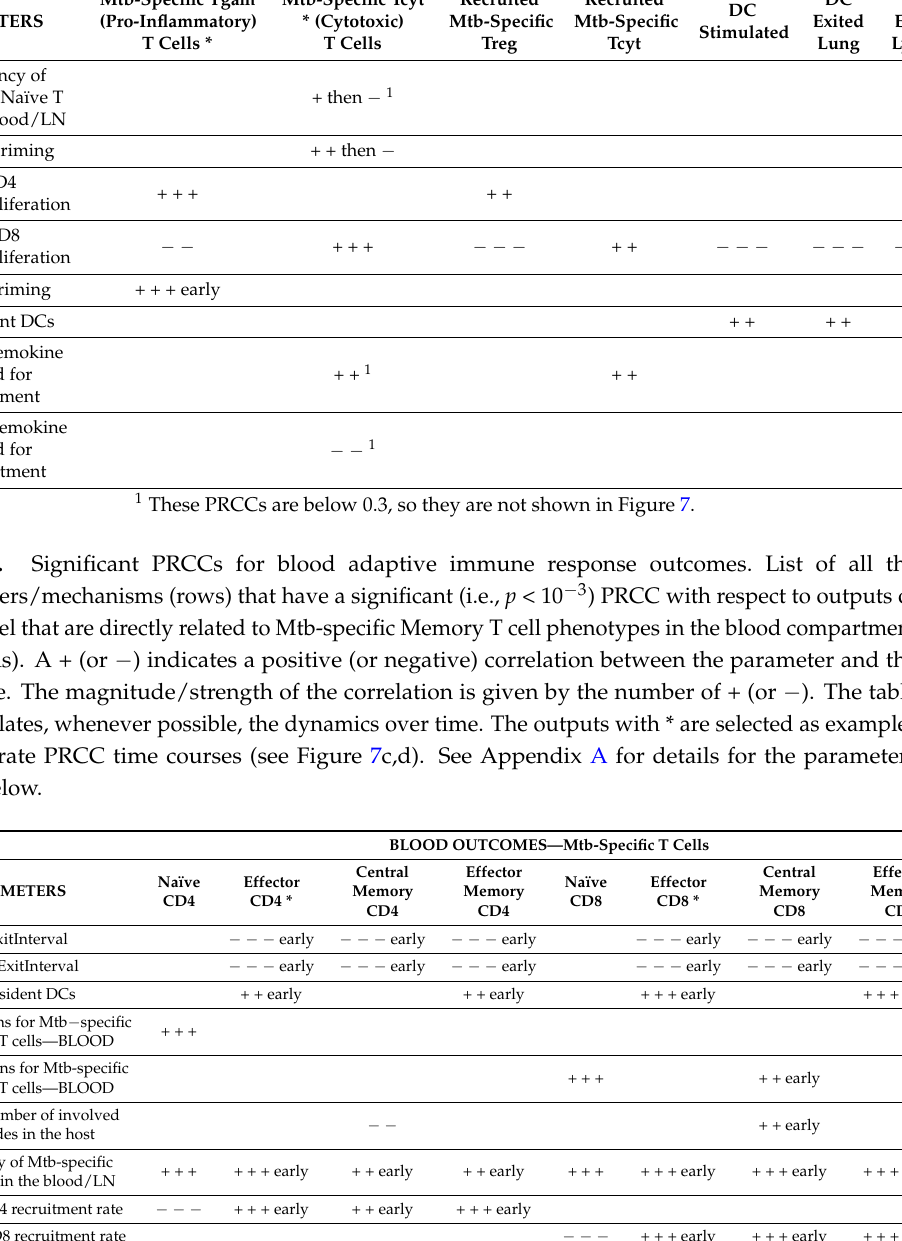
Table 4. Significant PRCCs for lung adaptive immune response outcomes. List of all the parameters/mechanisms (rows) that have a significant (i.e., p < 10 − 3 ) PRCC with respect to outputs